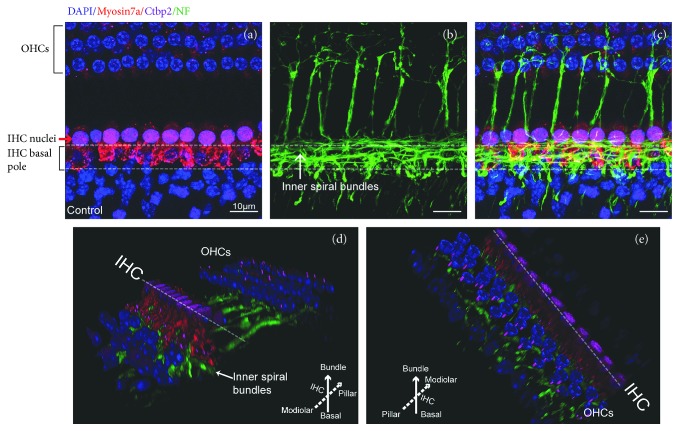
Spatial distribution of cochlear ribbons in IHCs and their relationship with inner spiral bundles in the normal mouse mature cochlea. The HCs, presynaptic ribbons, and nerve fibers were identified by immunostaining for myosin 7a (red), Ctbp2 (magenta), and neurofilament (NF) (green), respectively. Nuclei were labeled with DAPI (blue). (a) Ctbp2-positive ribbons (magenta puncta) were distributed at the basal poles of the IHCs and below the IHC nuclei. The IHC nuclei are marked with a red arrow. (b) NF staining showed that the ISBs appeared as nets of nerve fibers that include radially directed dendritic terminals of type I ANFs and efferent fibers of the olivocochlear system. (c) Merged images of (a) and (b). The IHC basal poles were surrounded by ISBs. (d, e) The 3D-reconstructed images showing the spatial relation among IHCs, presynaptic ribbons, and ISBs. (d) View from the modiolar side to the pillar side. (e) View from the pillar side to the modiolar side. IHC: inner hair cell; OHC: outer hair cell; ISBs: inner spiral bundles; ANFs: afferent nerve fibers. Scar bar = 10 μm.